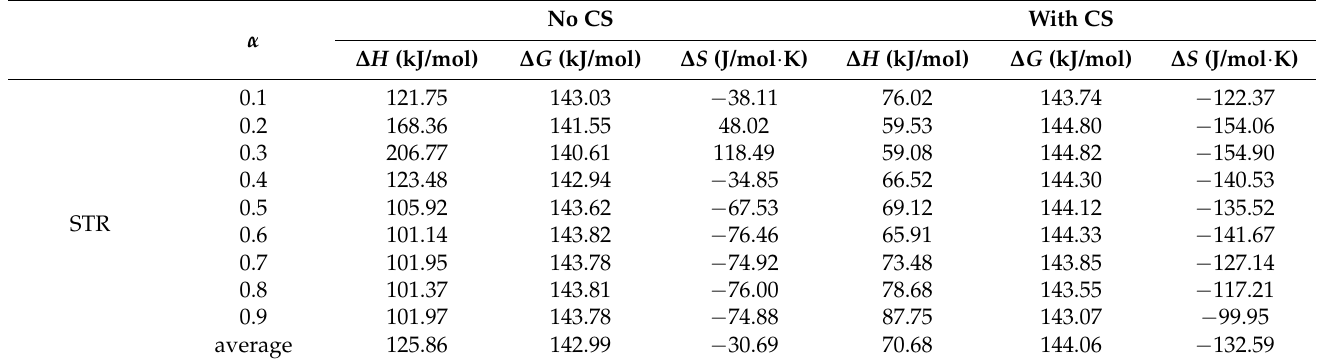
Table 5. Thermodynamic parameters of WCO-Biodiesel and blends of WCO-Biodiesel with CS at different α